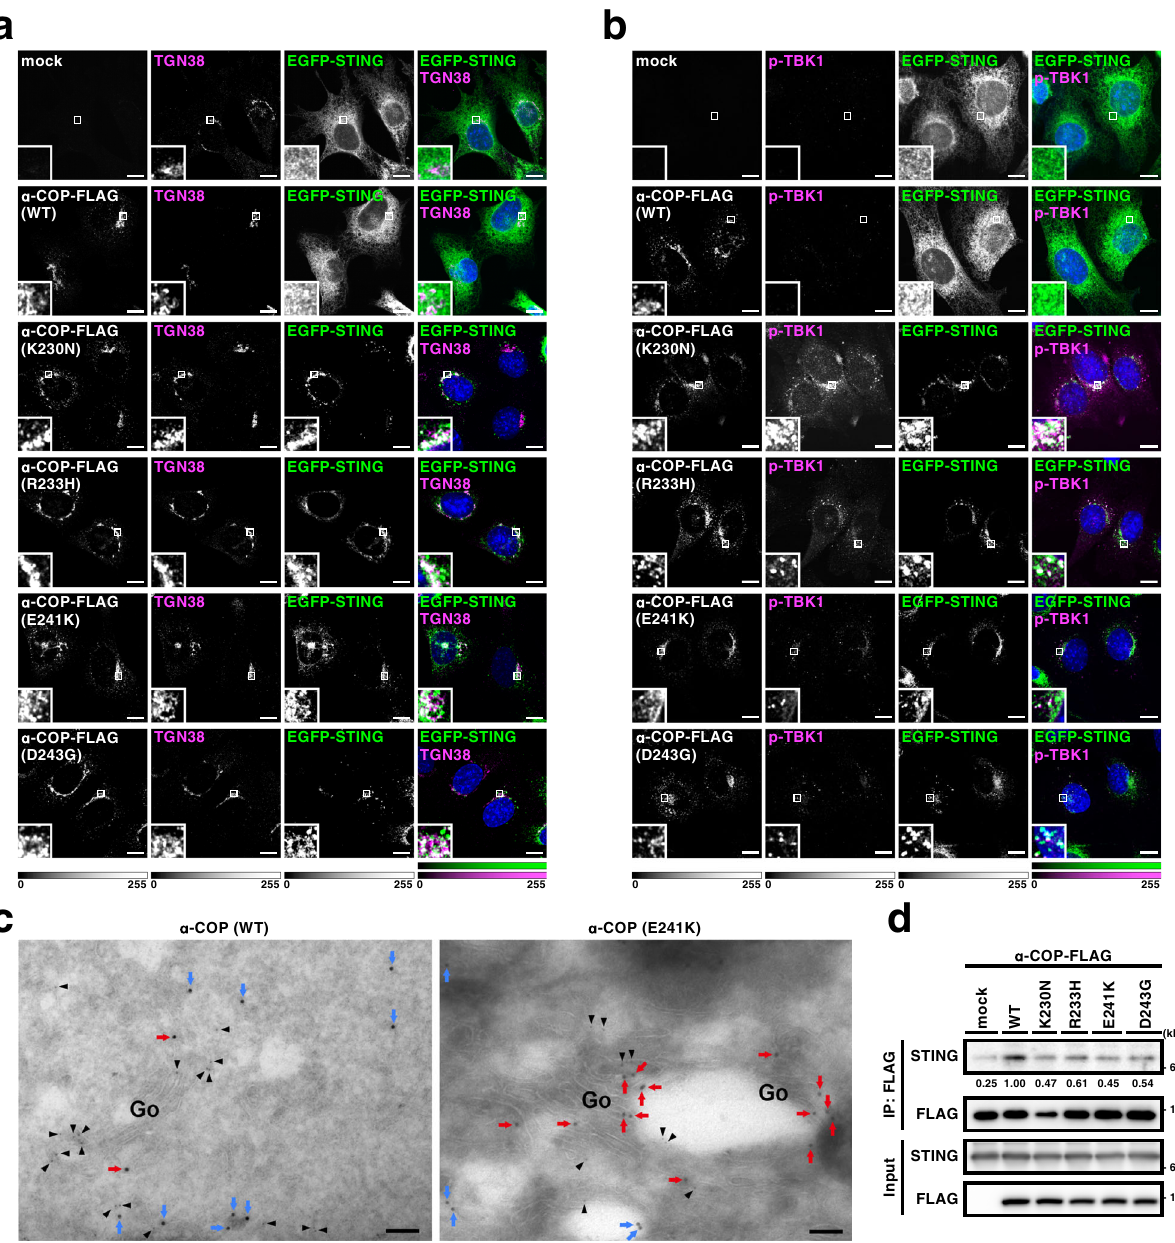
Fig. 2 The α -COP variants alter STING localization to the Golgi. a , b α -COP and EGFP-STING were stably expressed in Sting − / − MEFs as indicated. Cells were fi xed, permeabilized, and stained for TGN38 (a Golgi protein) ( a ) or p-TBK1 ( b ). Nuclei were stained with DAPI (blue). Color scales and intensity levels are indicated below images. Scale bars, 10 µ m. c α -COP-FLAG (WT) or α -COP-FLAG (E241K) was stably expressed in EGFP-STING-reconstituted MEFs. Cells were fi xed and processed for ultrathin cryosections. They were immunostained with anti-GFP (rabbit) and anti-FLAG (mouse) antibodies. As secondary antibodies, colloidal gold particle-conjugated donkey anti-rabbit antibody (12 nm) and anti-mouse (6 nm) were used. Arrowheads indicate α -COP signal, red arrows indicate GFP signal on the Golgi, and blue arrows indicate GFP signal that was not associated with the Golgi. Go, the Golgi stack. Scale bars, 500 nm. d Cell lysates were prepared from MEFs expressing various α -COP as indicated, and α -COP was immunoprecipitated with anti-FLAG antibody. Cell lysates and the immunoprecipitates were analyzed by western